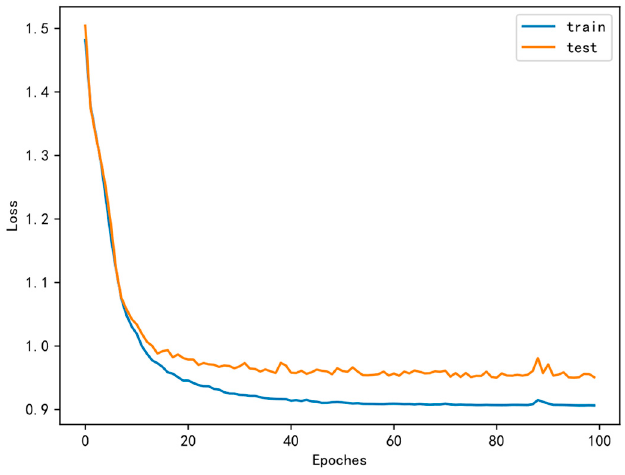
Figure 4. The loss value of the proposed 1D-CNN model.